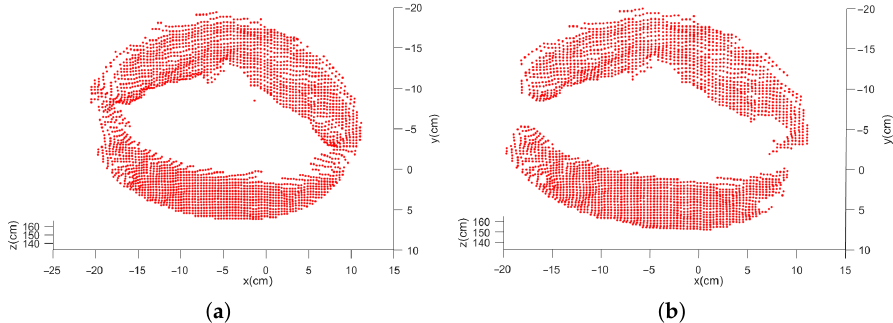
Figure 14. ( a ) The final results of the direct segmentation; ( b ) final results of the segmentation assisted by gray